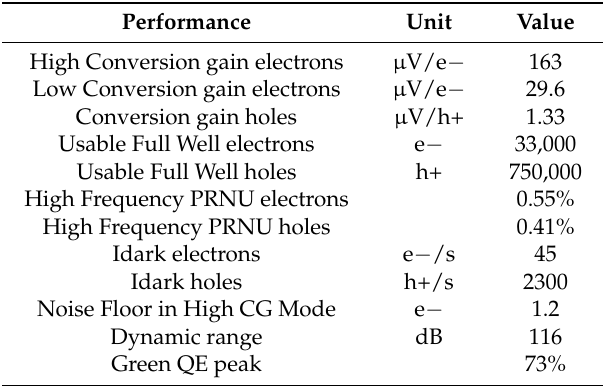
Table 3. Measured optical